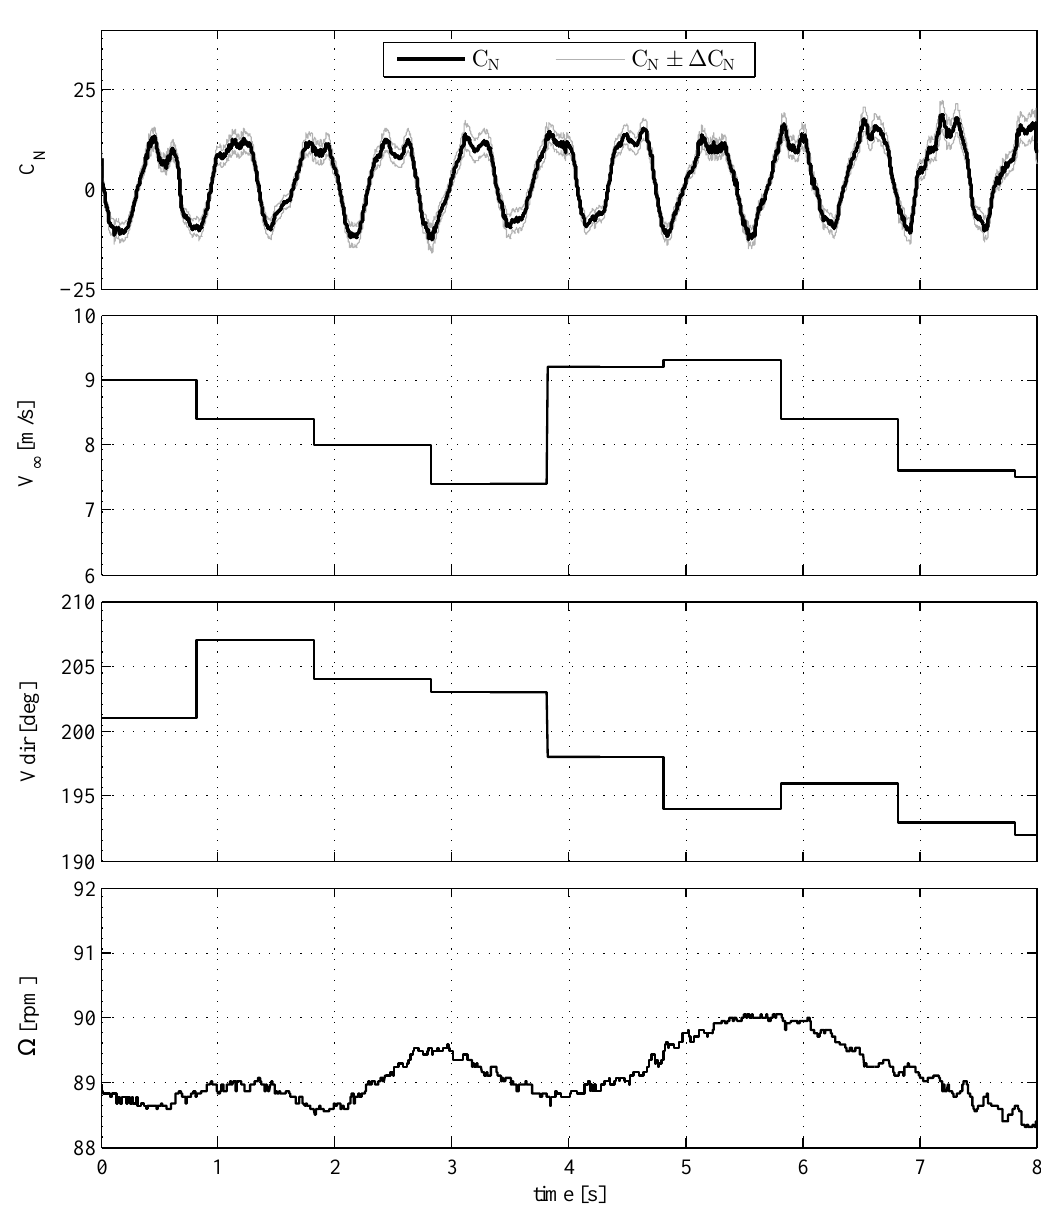
is measured 15 m ∞